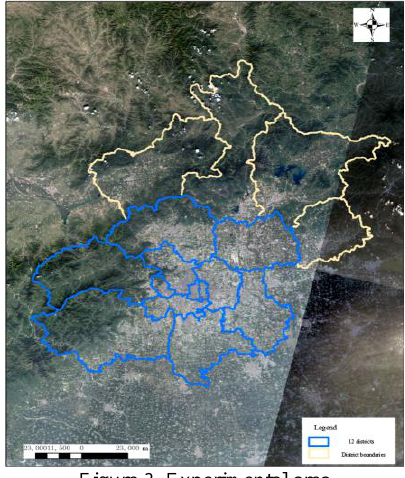
Figure 3. Experimental area